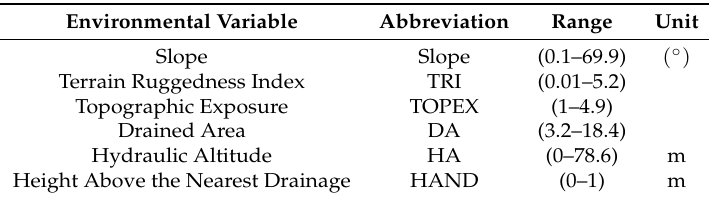
Table 1. The six environmental variables used in this study, with description, abbreviation, and observed